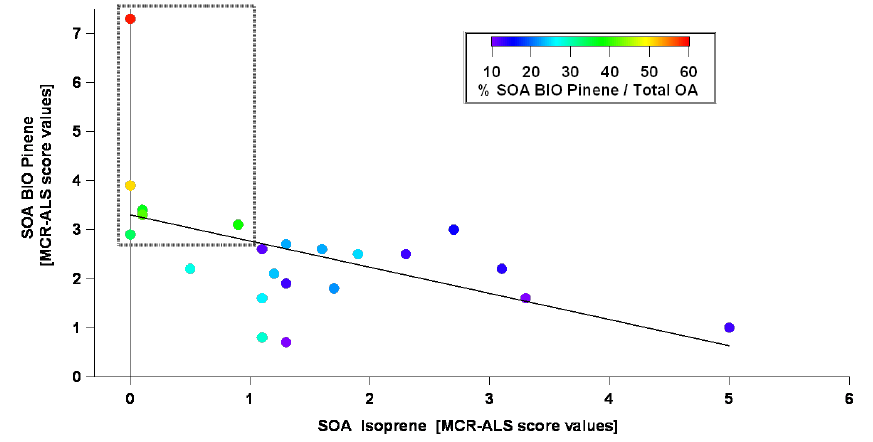
Fig. 4. MCR-ALS scores values for SOA isoprene and SOA BIO pinene for daytime samples (09:00–21:00) collected during SAPUSS. Please note the rectangle in figure includes the five nucleation days seen during SAPUSS (25, 26, 27 September, 5 and 18 October